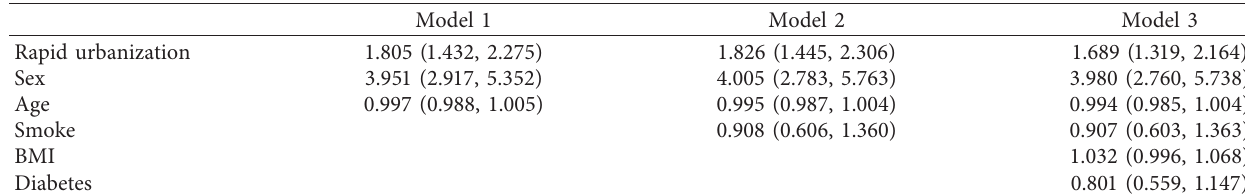
Table 3: Logistic regression analysis for risk factors for TGAb positivity.